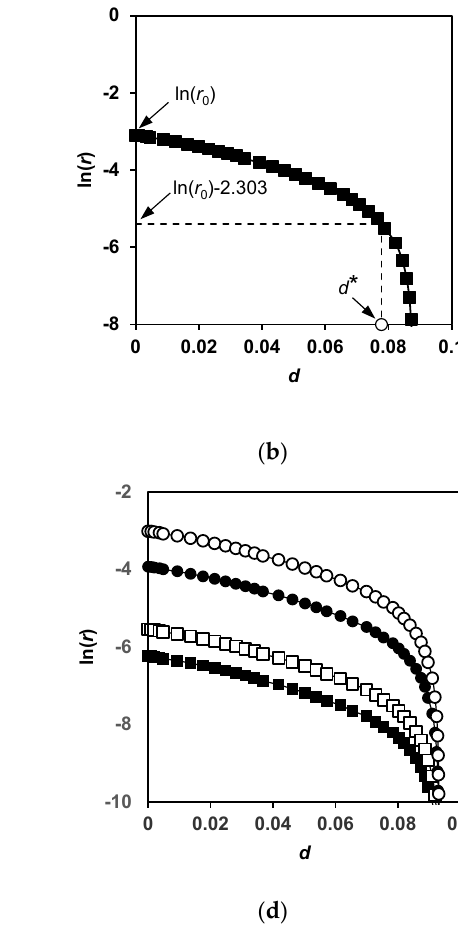
Figure 5. Dependences of the logarithm of hydrolysis rate ln( r ) on degree of hydrolysis d : ( a ) experimental data ( ▲ ) and calculated dependences for κ m = 0.05 at ε = 0.2 ( ● ), 0.4 ( □ ), 2 ( ■ ), and 5 ( ○ ); ( b ) illustration of the definition of d * value ( ○ ); ( c ) simulated dependences for ε = 2 at κ m = 0.05 ( ■ ), 0.025 ( □ ), 0.012 ( ● ), and 0 ( ○ ); ( d ) simulated dependences for κ m = 0 at ε = 0.2 ( ■ ), 0.4 ( □ ), 2 ( ● ), and 5 ( ○ ).